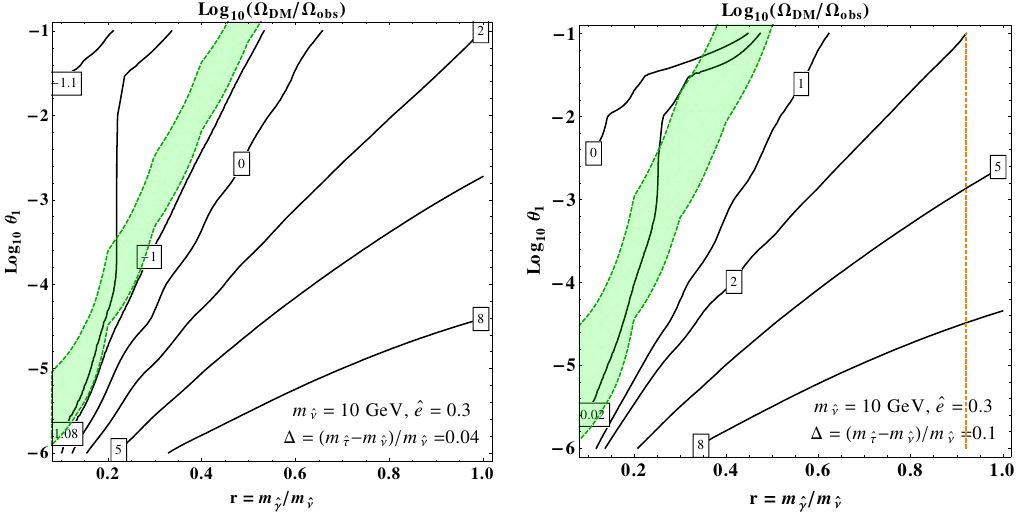
Figure 6 . Similar to (cid:12)gure 4, but for m ^ (cid:23) = 10 GeV and (cid:1) = 0 : 04 and